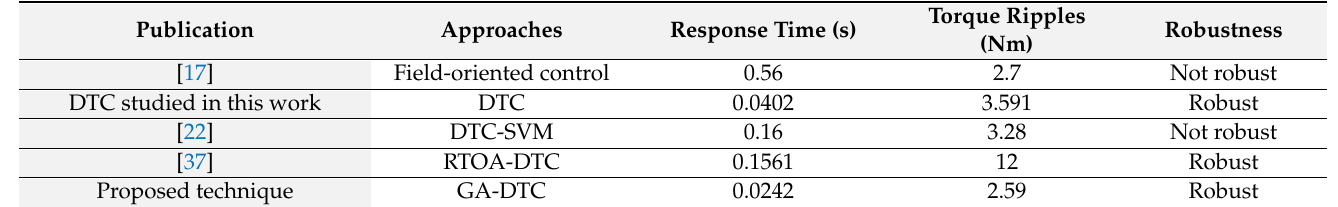
Table 5. Comparison between our proposed approach and some control strategies published